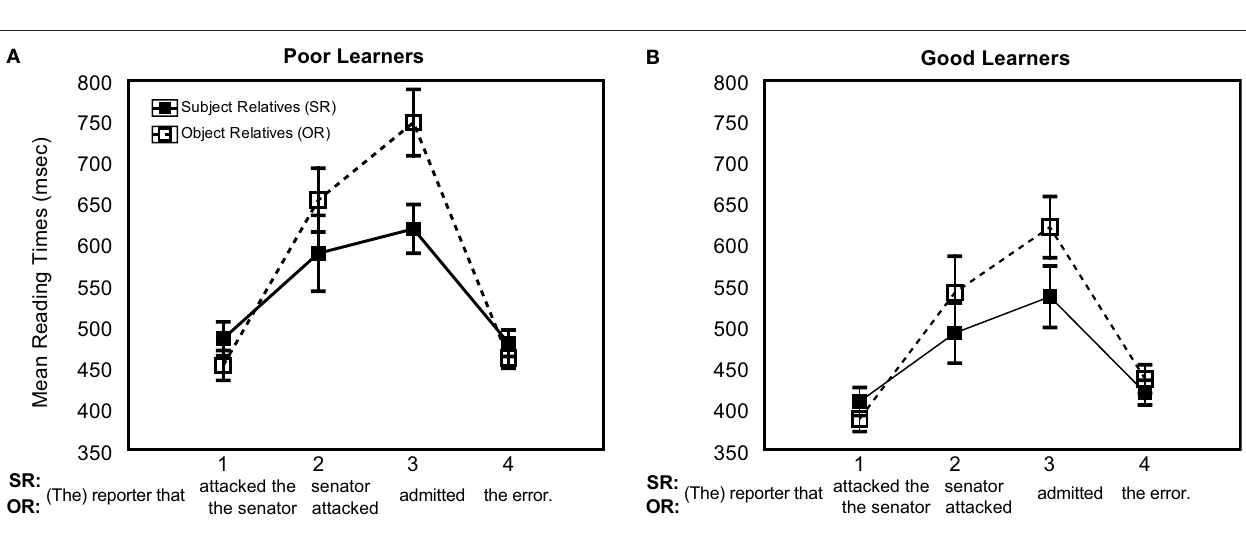
Figure 4 | Correlation of AgL-SrT on-line learning scores (experiment 1) with reading times (experiment 2) at the main verb of (A) subject relatives and (B) object relatives.